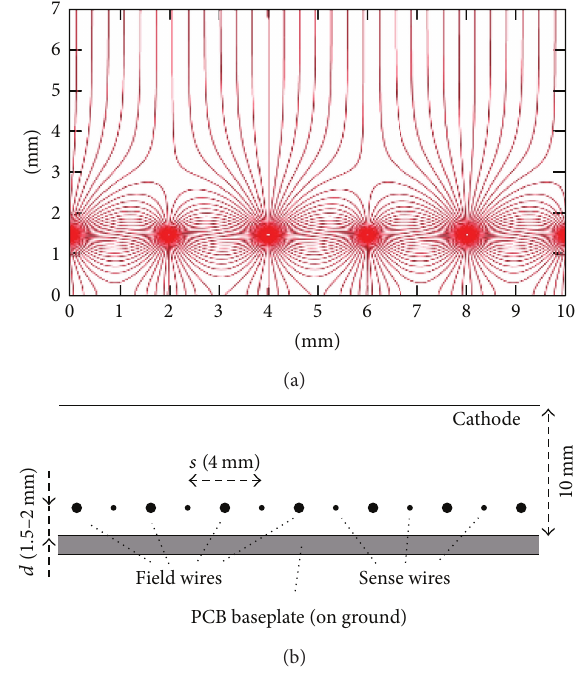
Figure 2: (a) The electric field in a Close Cathode Chamber, based on simulation. (b) The inner structure of a CCC chamber in a cross section [7, 8].